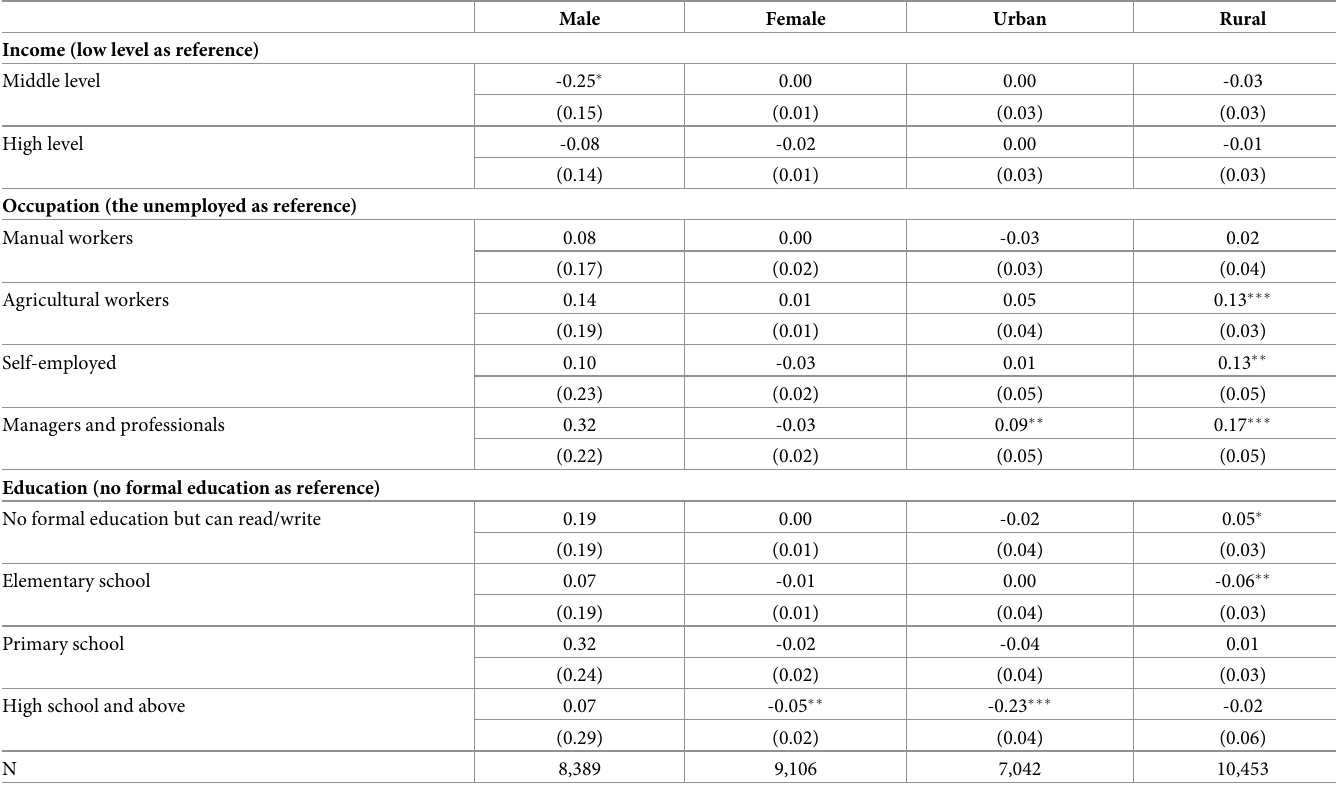
Table 3. Association between SES and cigarette consumption using the sample selection model /OLS: Coefficient with standard